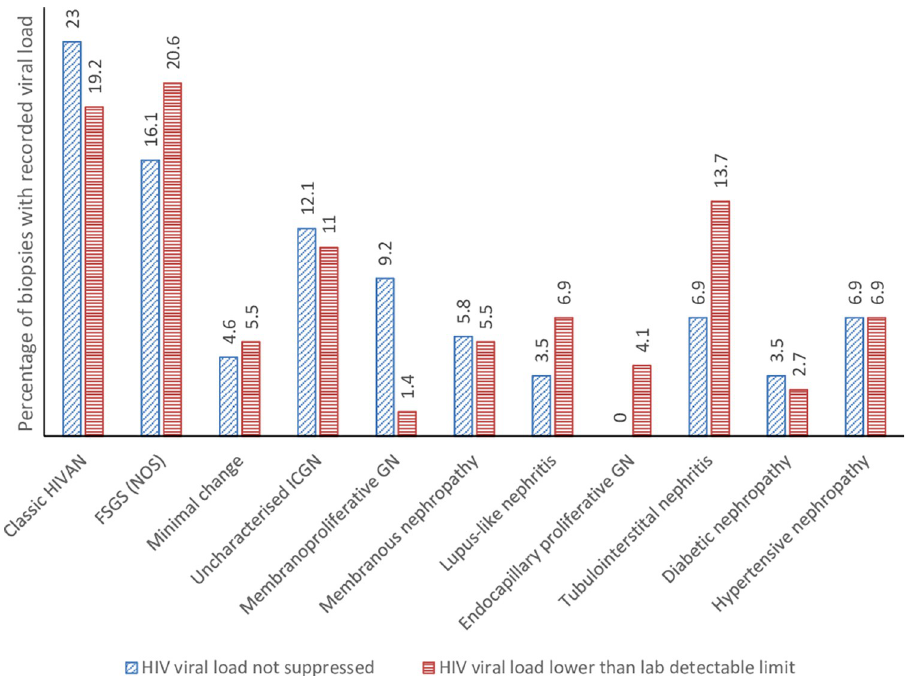
Fig 3. Percentage of patients achieving viral load suppression among glomerular-dominant lesions in HIV- positive patients who underwent a native kidney biopsy.